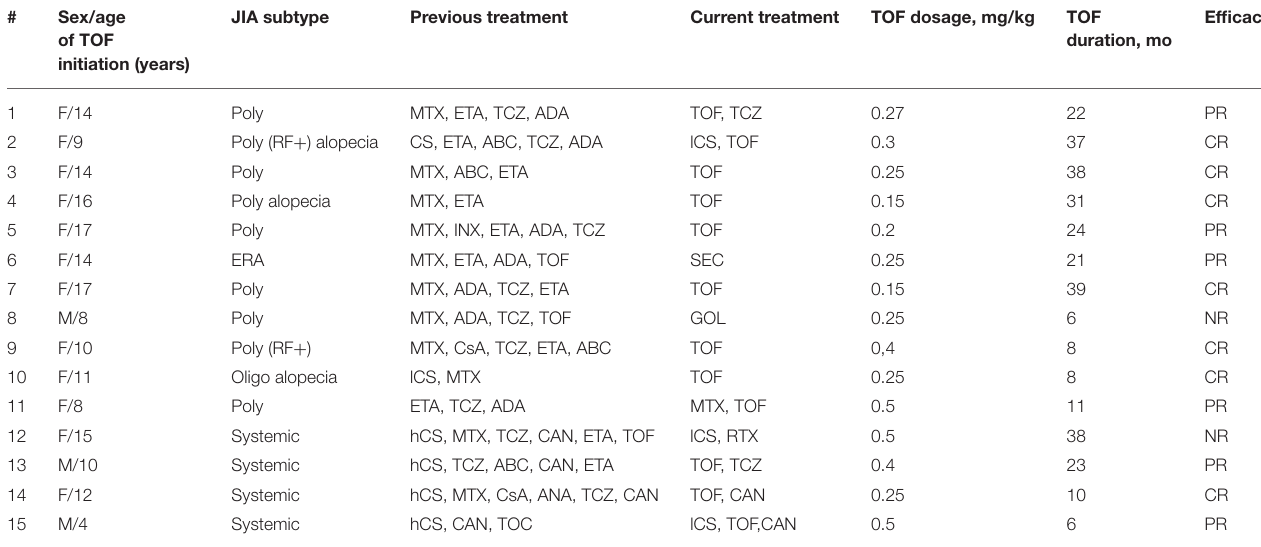
TABLE 2 | Treatment modalities in patients with juvenile idiopathic arthritis. # Sex/age of TOF